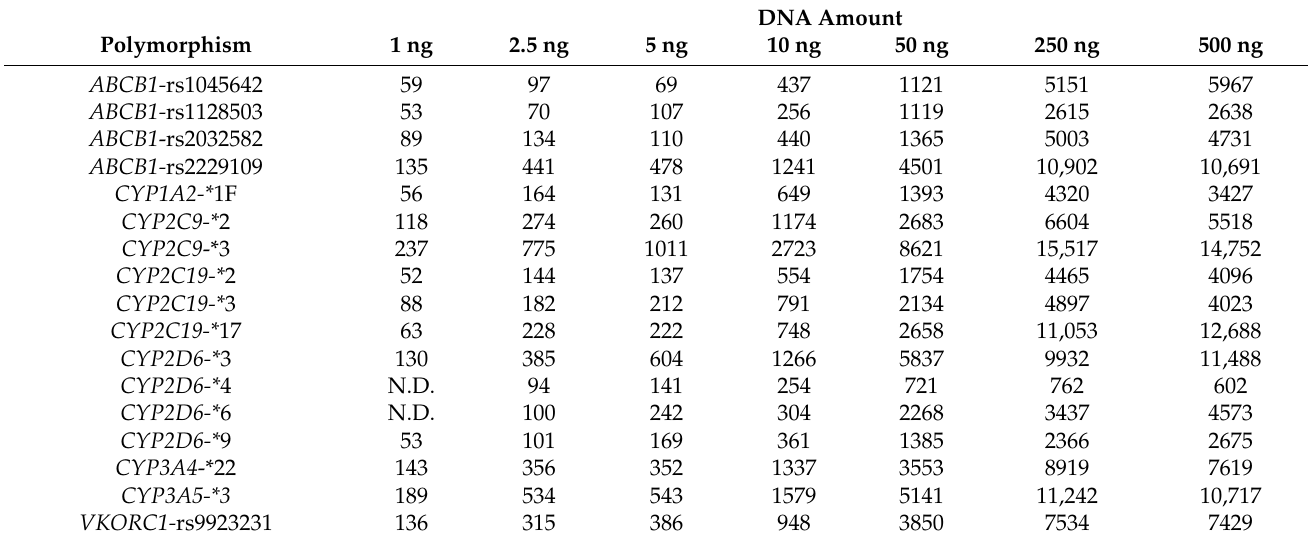
Table 2. Influence of the amount of DNA analyzed on the performance of the analysis, expressed as peak intensity.